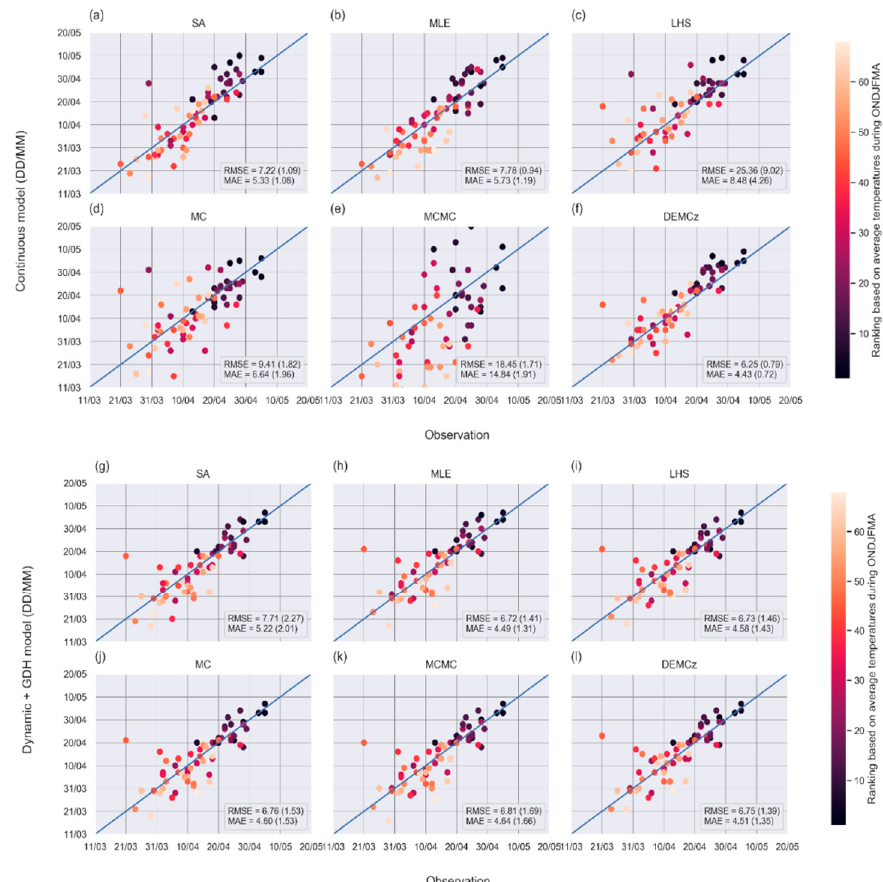
Figure 7. Performance of the continuous model ( a – f ) and the dynamic + GDH model ( g – l ) for ‘Conference’ to predict bloom date. Colors represent the position in the ranking based on average temperature during the full dormancy phase (October to April), with dark tones representing the cold years. RMSE and MAE values refer to the entire period, the values in brackets give the ratio of the respective error for the warm 25% of the years over the cold 25% of the years. For improved visibility, some points are omitted. As reference, the identity lines are shown (x = y, in blue).